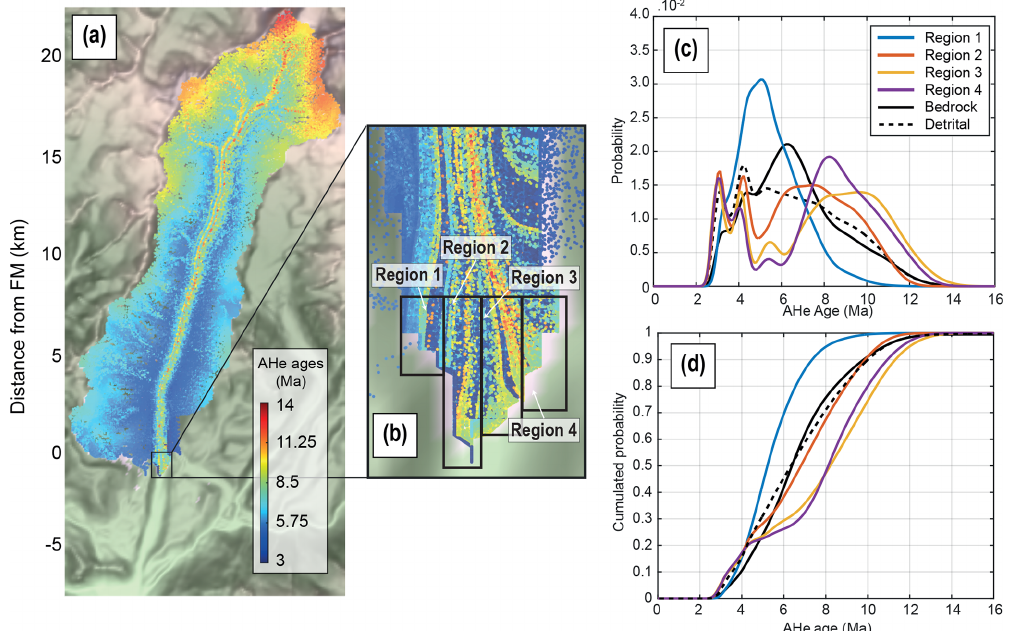
Figure 11. Detrital AHe age distributions of the five regions seen in (b) (black rectangles) from the experiment considering a uniform source of particles. Spatial distribution of particles with their associated AHe ages (a) , with a zoom-in of the frontal moraine area in (b) . The density plots and their cumulative distributions are shown in (c) and (d) . The dashed black line is the mean detrital SPDF for the frontal moraine